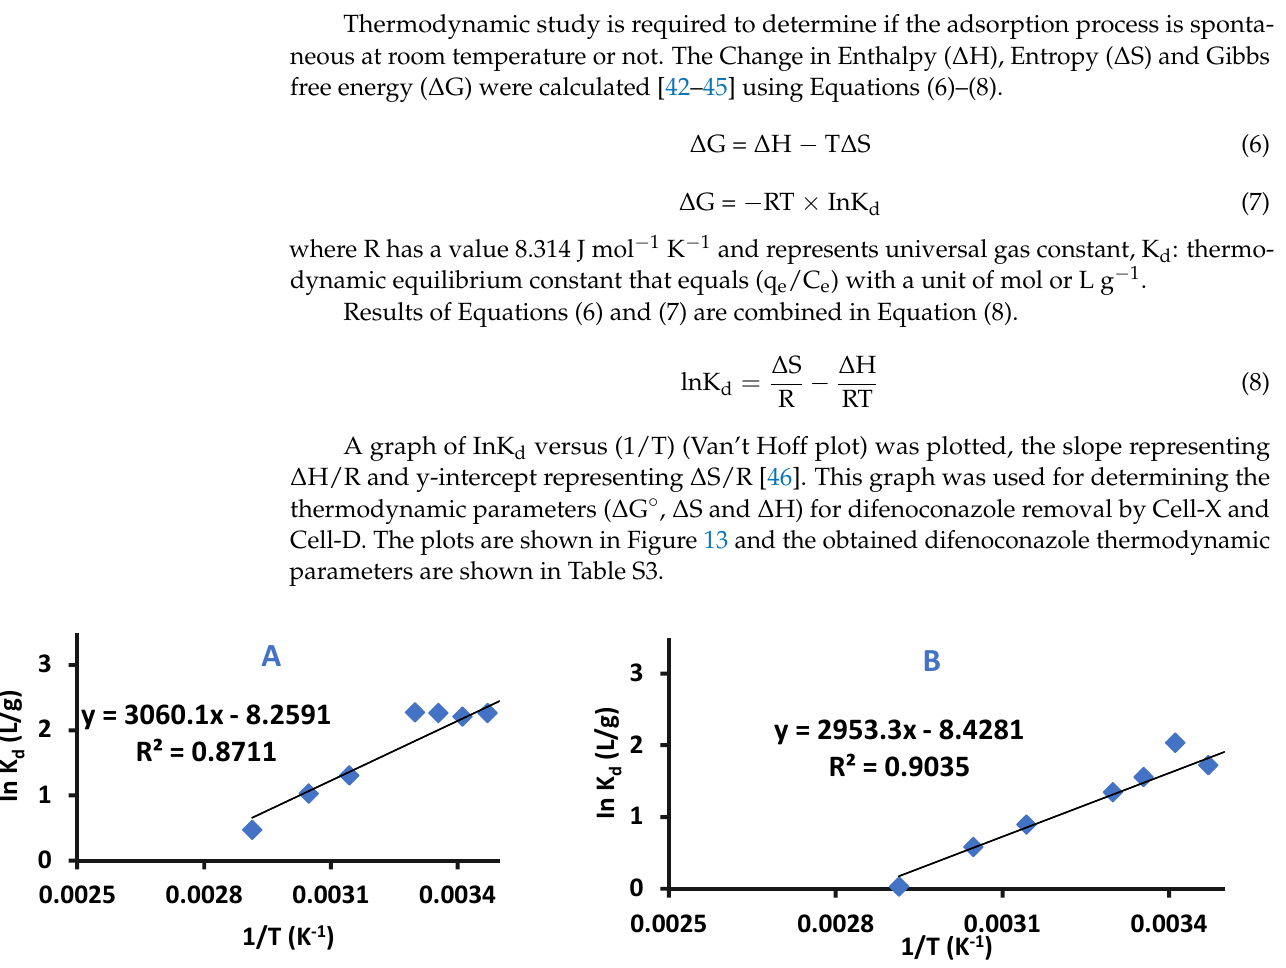
Figure 12. Pseudo-first-order ( A ), Pseudo-second-order ( B ), and Intra-particle-diffusion kinetic ( C ) for difenoconazole re- moval by Cell-X. (C I : 10 ppm, volume: 10 mL, pH: 7, temperature: 20 °C, dose = 10 mg).